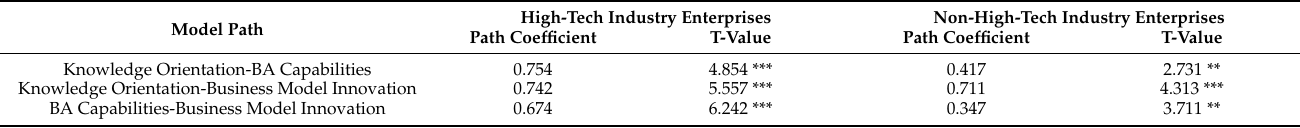
Table 7. Comparative analysis of the path coefficients of the relationship between knowledge orientation, BA capabilities, and business model innovation in enterprises of different industry types. Model